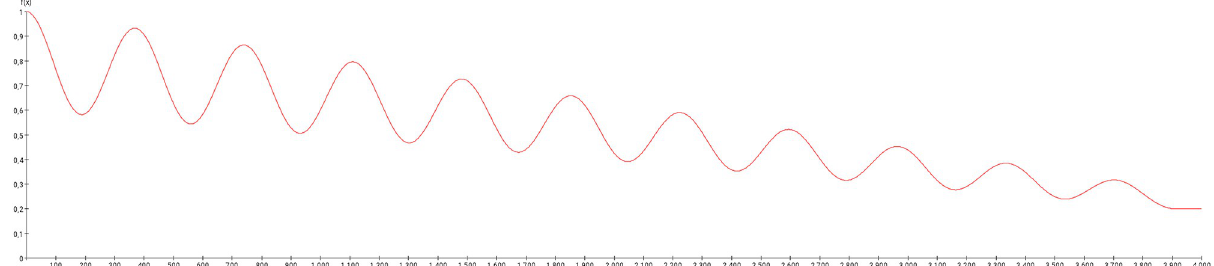
Fig 19. Weight modulation function. This weight modulation function (damped cosine function) is applied to the GM RD-system. Initial conditions V 0 = 1 and W 0 = 1 were set for the dorsal root ganglia of the left